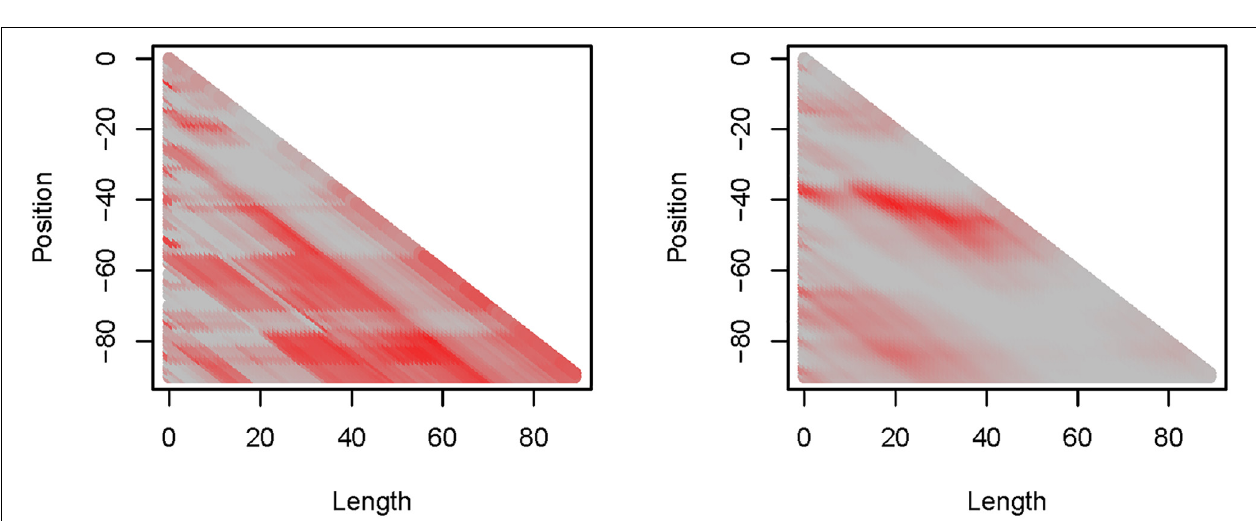
FIGURE 2 | Illustration of the sliding window approach in 2010 for the daily average temperature. Each time window is defined by its length (in nights, therefore 0 includes 24 h) and position (starting point in days, with the mean annual laying date being day 0).